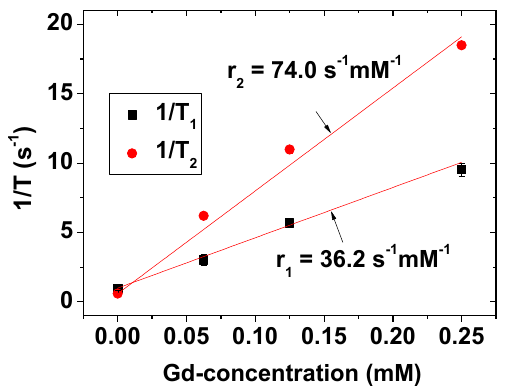
Figure 6. Plots of 1/T 1 and 1/T 2 as a function of the Gd-concentration. The slopes correspond to r 1 and r 2 values, respectively.